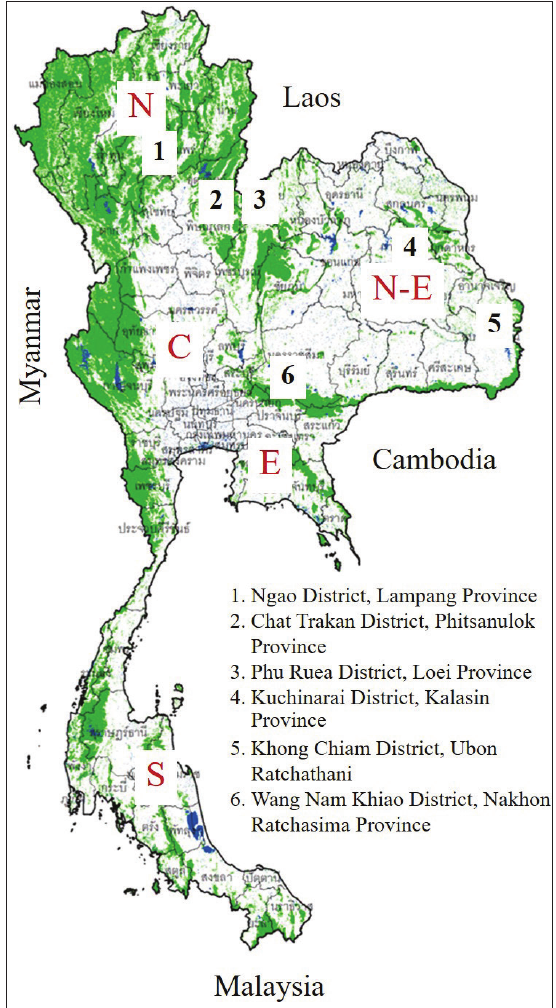
Figure 1. Specimen collecting localities, the ordinal numbers in accordance with the sequence of loca- tions in the text. N=Northern region, N-E=North-Eastern region, C=Central region; E=Eastern region, S=Southern region. Source: map modified from a Royal Forest Department of Thailand